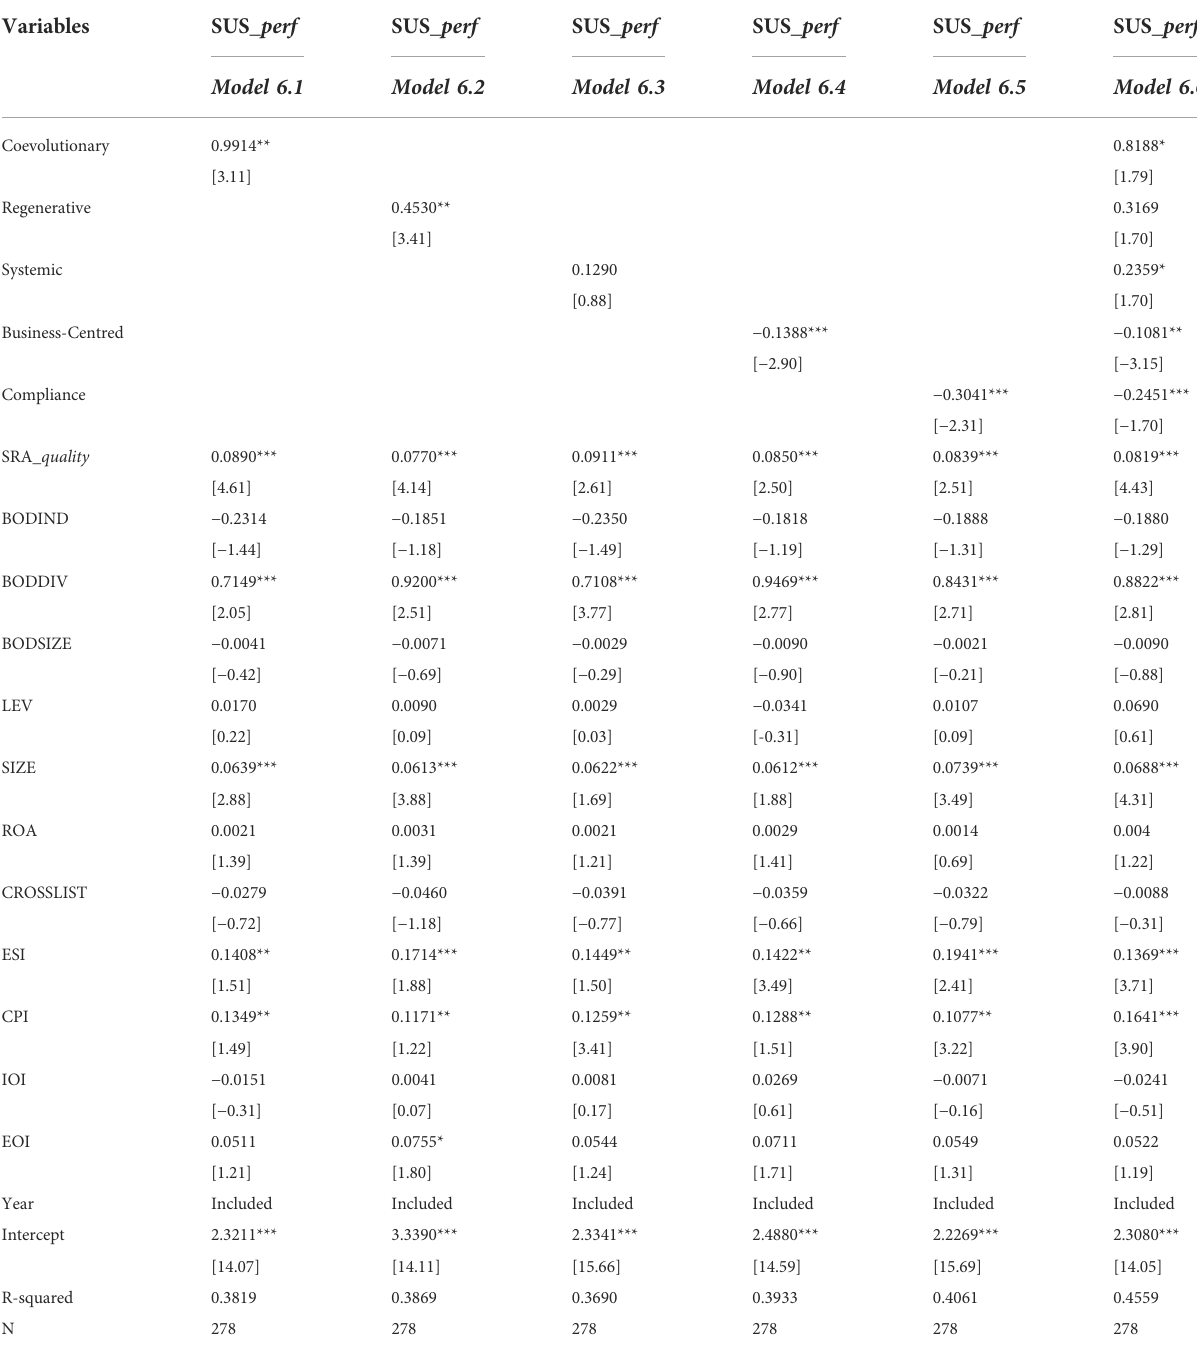
TABLE 6 Additional analysis: Industry